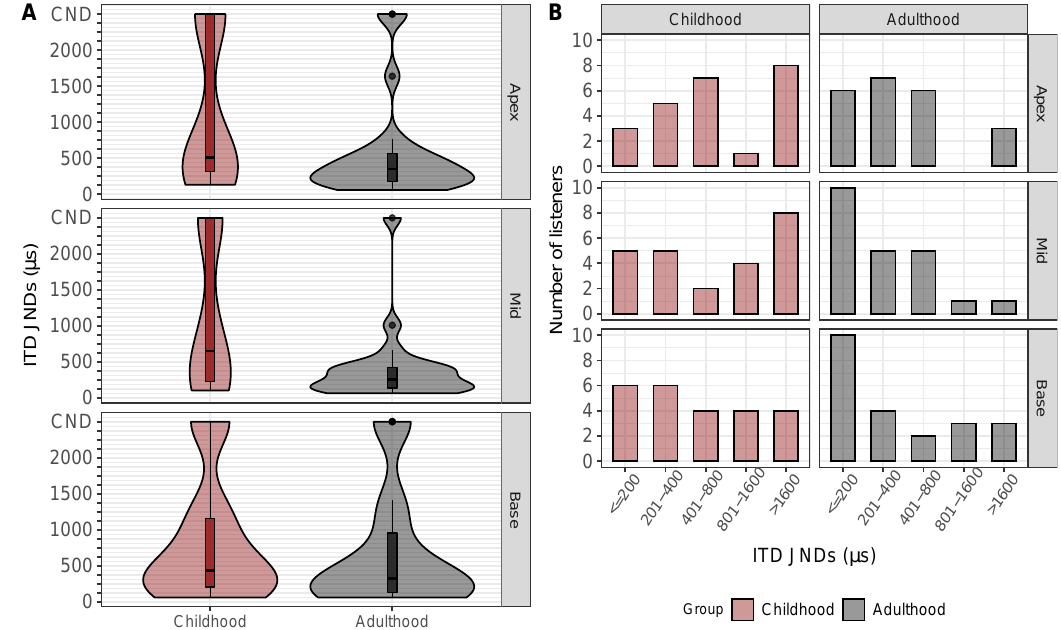
Figure 6. Shows the distribution of ( A ) ITD Just-noticeable di ff erences (JNDs) as a box plot and violin plot for all listeners as a function of age at onset of the deafness group. A wider distribution (i.e., greater thickness) on a violin plot corresponds to a greater number of listeners with a given JND on the y-axis. Black dashed line indicates “could not determine” (CND) threshold for ITD JNDs. ( B ) Shows histograms of ITD JNDs, for each age group, binned according to levels of performance ranging from “good” ( < 200 µ s) to “poor” ( > 1600 µ